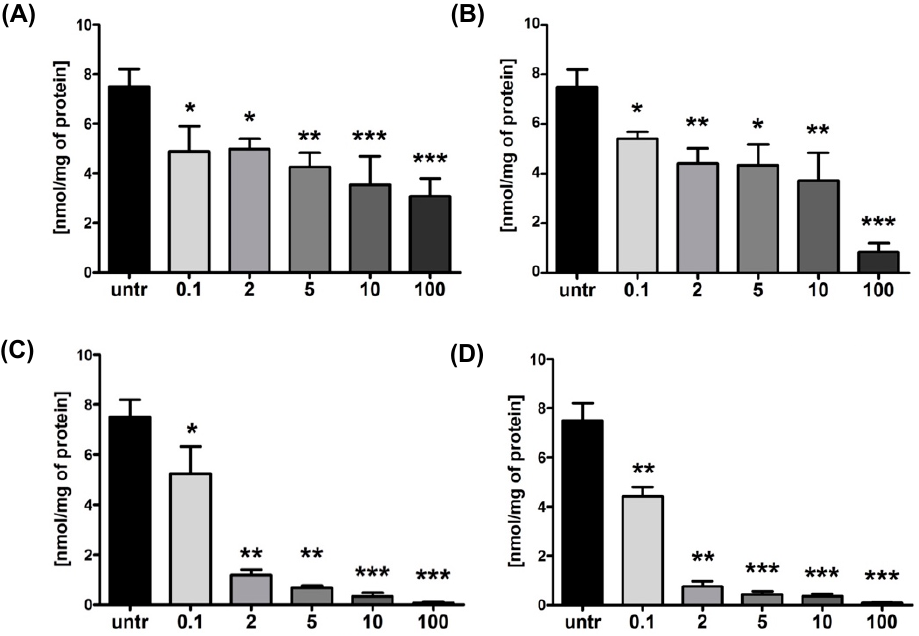
Figure 4. Concentration of 1-methyl nicotinamide (MNA) in A549 lung carcinoma cells after 24-h treatment with 0.1–100 µM of compounds: ( A ) 6-MANA; ( B ) GYZ-319; ( C ) 12e; and ( D ) 14e. n = 6, * p ≤ 0.05, ** p ≤ 0.01, *** p ≤ 0.001 compared to untreated control (untr).